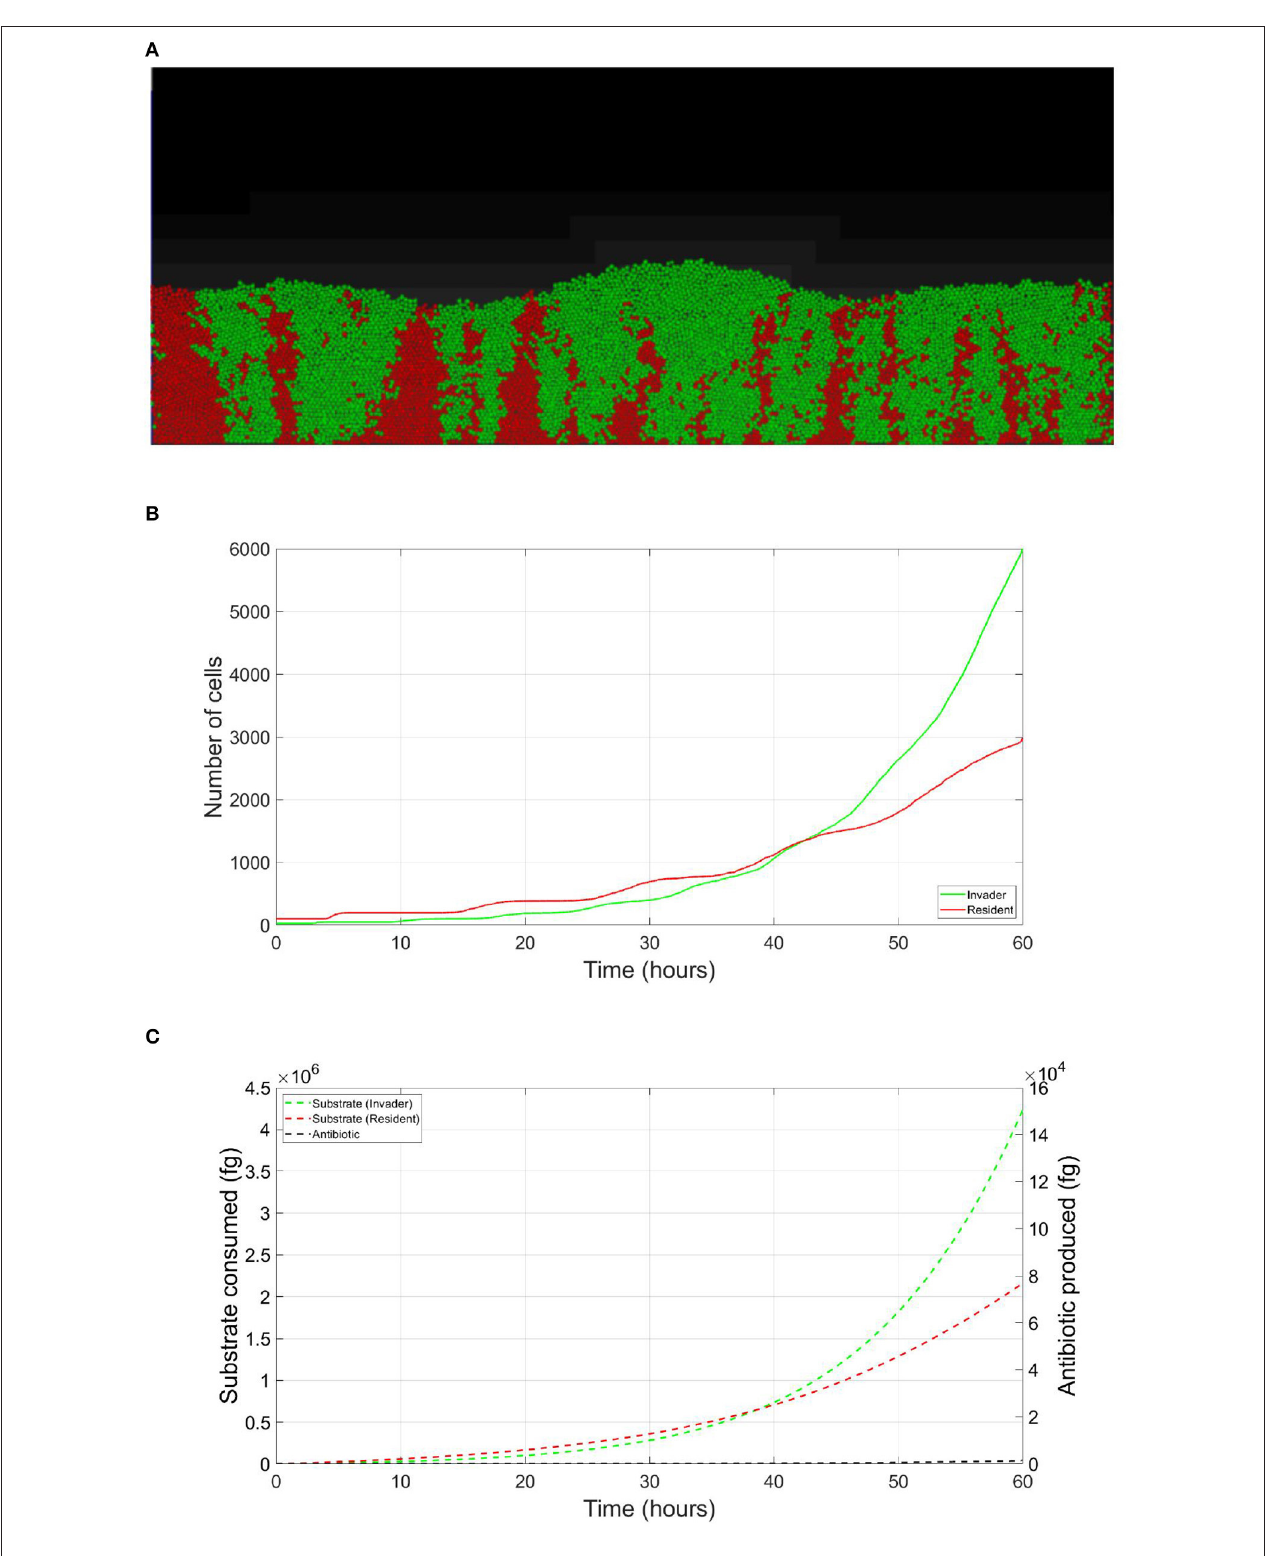
FIGURE 3 | Competition tolerance, signaling scenario: by switching to low growth rate/ high yield strategy, the resident species can achieve more efficient usage of resources, avoiding triggering of the release of the expensive antibiotic by the invader, both parties avoid a costly fight. (A) A snapshot of the competition between the invader species (green) vs. the resident species (red), by the end of the simulation. (B) The evolution of the population of an antibiotic producing invader and a resident species, growing on the same nutrient, with the resident species adopting low growth rate/ high yield strategy. (C) The evolution of the consumption of the nutrient by the invader species (green), and the resident species (red), as well as the production of antibiotic by the invader species (black).